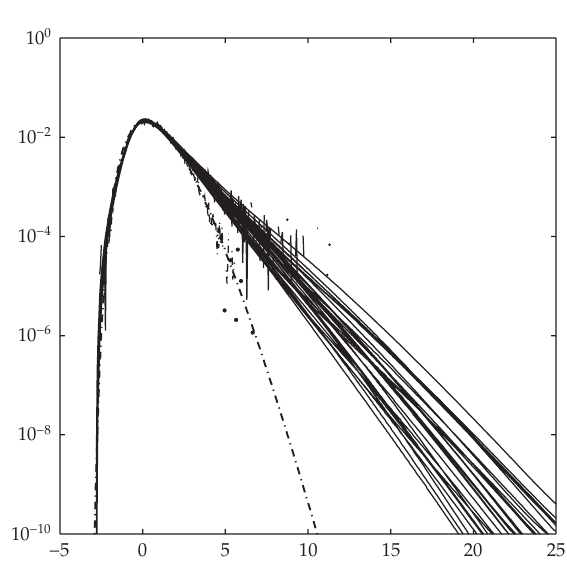
(cid:2) u (cid:3) using the N